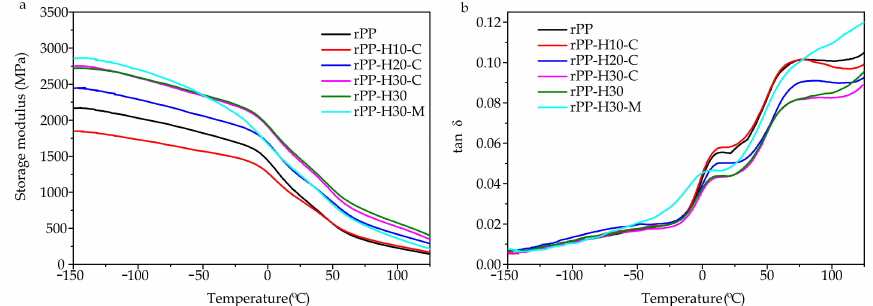
Figure 5. Comparative plots of the evolution of ( a ) storage modulus (E’), and ( b ) glass transition temperature ( T g ) as a function of the temperature of rPP pieces and the rPP/hemp fiber composites with different